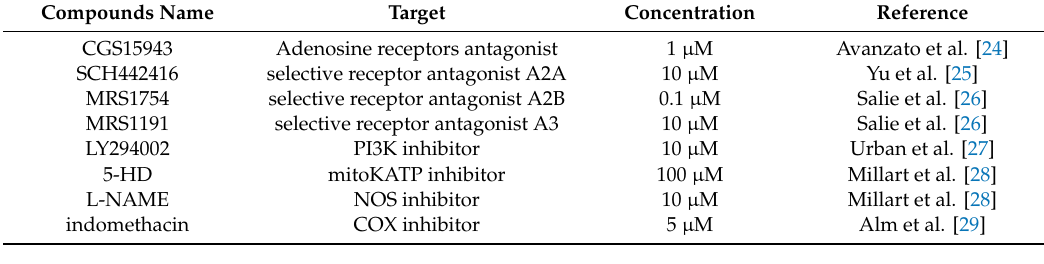
Table 1. Listing of inhibitors and antagonists used in the study. This table described di ff erent inhibitors and antagonists used for experiments. Concentrations and reference were also noticed.